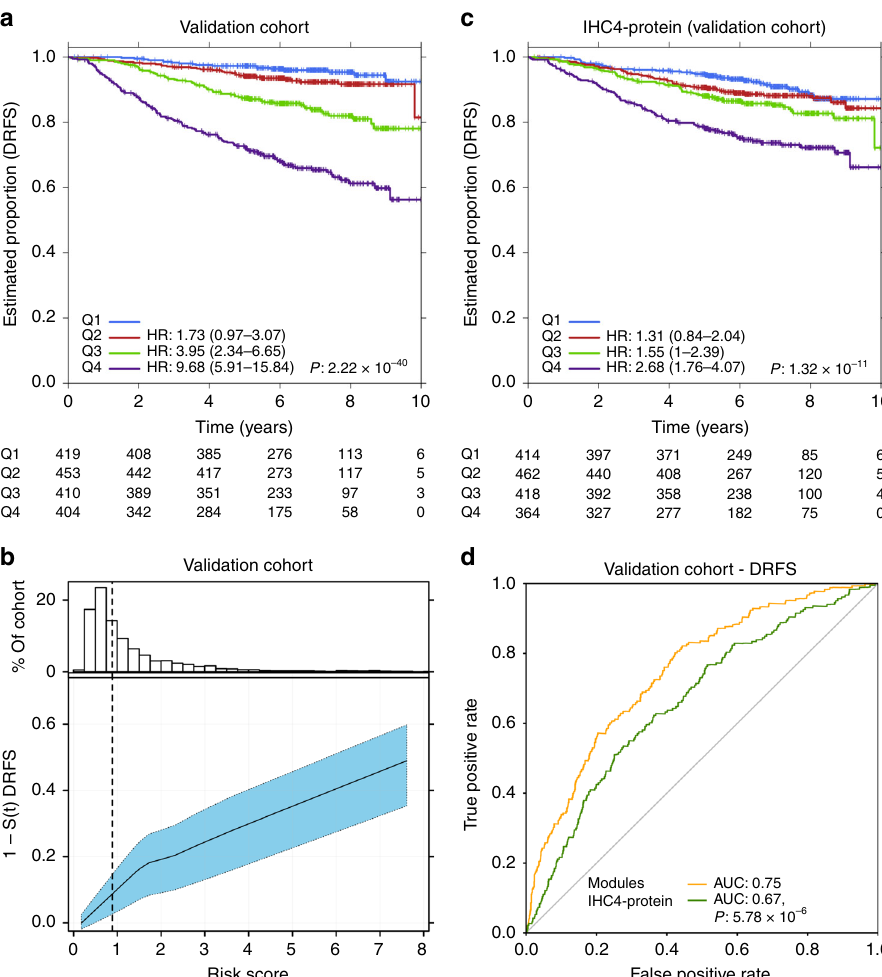
Fig. 5 PIK3CA signaling predictor of breast cancer recurrence. a Independent validation of prognostic model trained on SIMMS ’ risk scores and clinical covariates (N and tumor size). Risk score estimates were grouped into quartiles derived from the TEAM training cohort; each group was compared against Q1. Hazard ratios were estimated using Cox proportional hazards model and signi fi cance of survival difference was estimated using the log-rank test assessing heterogeneity across the four groups. b Distribution of patient risk scores in the TEAM Validation cohort (top panel). Bottom panel shows the predicted 5-year recurrence probabilities (solid line) and 95% CI (dashed lines) as a function of patient risk score. Vertical dashed black line indicates training set median risk score. c Risk prediction by the IHC4 protein model in the TEAM validation cohort. Quartiles were de fi ned in the training cohort and applied to the validation cohort. Quartiles Q2-Q4 were compared against Q1, with adjustment for age, nodal status, tumor size and grade using Cox proportional hazards modeling and the log-rank test. d Comparison of SIMMS ’ modules model (PIK3CA risk predictor) and IHC4-protein model using area under the receiver operating characteristic (AUC) curve as performance